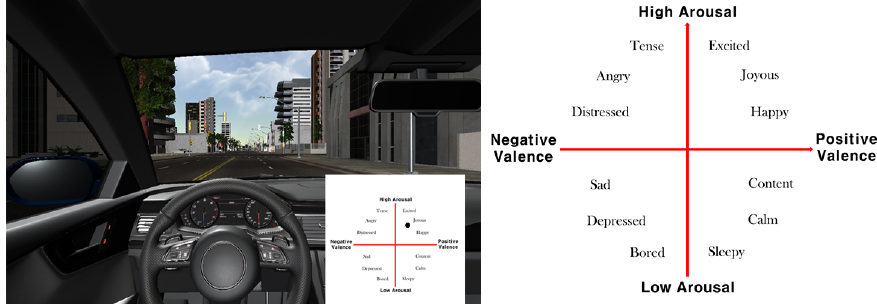
Figure 4. The front view of the subject and Valence and Arousal Annotation